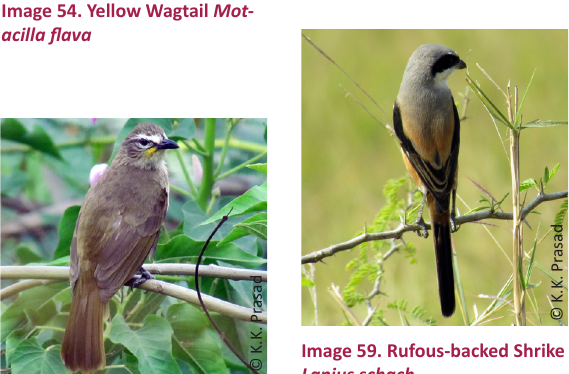
Image 59. Rufous-backed Shrike Lanius schach